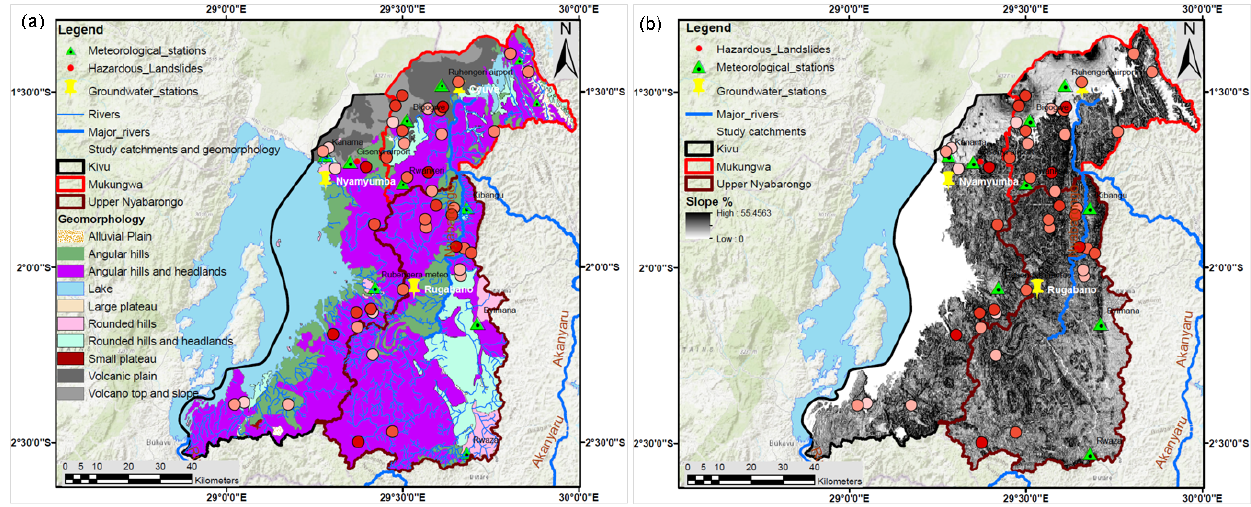
Figure 2. Geomorphological characteristics of the study catchments and landslides: (a) landforms and (b) slope; spatial and temporal distri- bution of landslides with light to dark red dots indicating old to new landslides recorded from 2006–2018 (Uwihirwe et al., 2020).